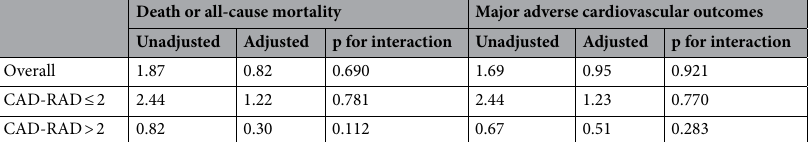
Table 4. Hazard ratios for the association of ML-FFR CT < 0.8 and incident outcomes. ML-FFR CT refers to fractional flow reserve derived using computed tomography and was categorized as < 0.8 Models were adjusted for age, hypertension, diabetes mellitus, dyslipidemia, ever cigarette smoking, indication for CCTA testing, early revascularization (PCI or CABG within 90 days of testing), and degree of coronary stenosis by CCTA. p-for interaction refers to multiplicative interaction between ML-FFR CT and sex (women vs. men).